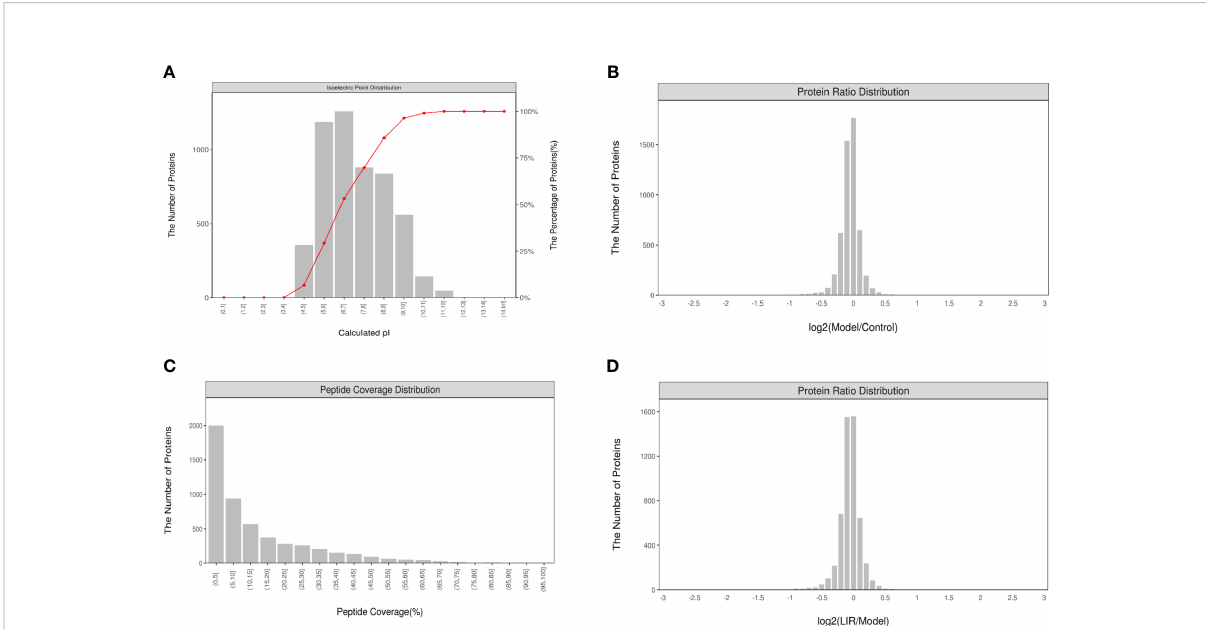
revealed that 43 differential proteins of Model/Control were up- regulated, and 30 were down-regulated after drug intervention (Figure 5A). To be speci fi c, the target proteins are PAPSS1, DAD1, CIAO1, DLGAP4, DCAF11, NSA2, ADAM10, PDCD10, PTPA, G-septin, Rmdn2, LRRC59, MRPS2, HMOX2,